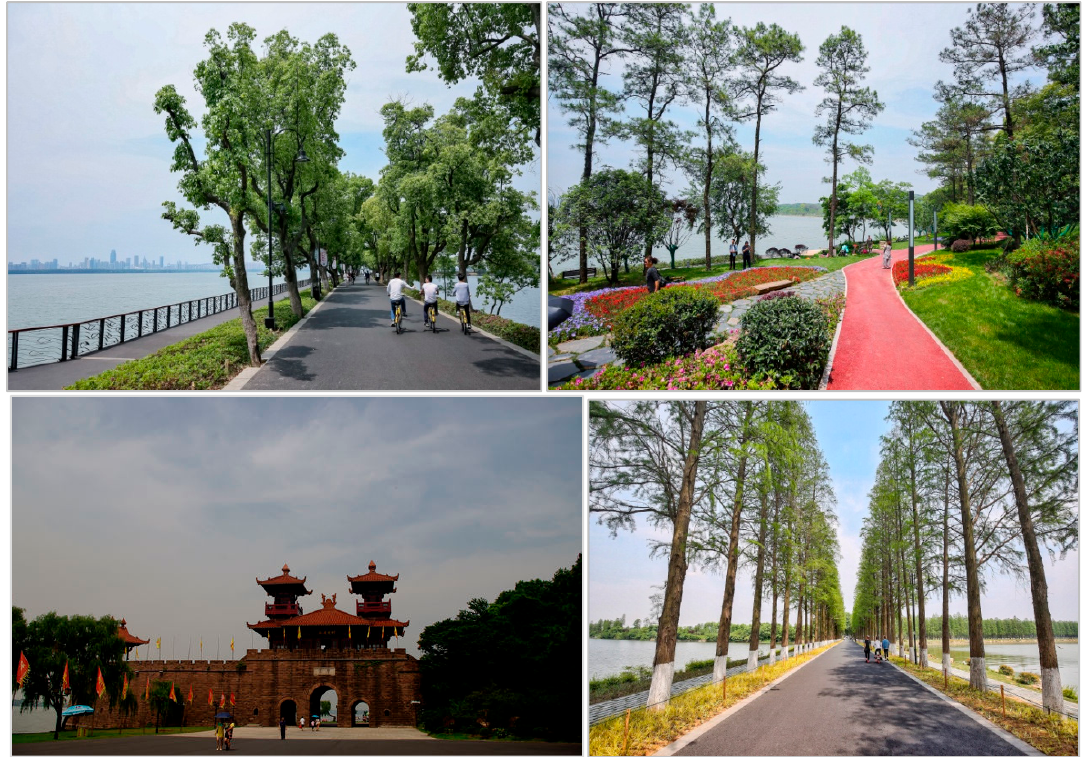
Figure 1. Some sceneries in Wuhan greenway （ Source: The left down one from http://blog.sina.com.cn/s/blog_51e387ef0100thc1.html. Others from https://m.weibo.cn/status/4103092829771911; Accessed: May.9, 2017. ） .